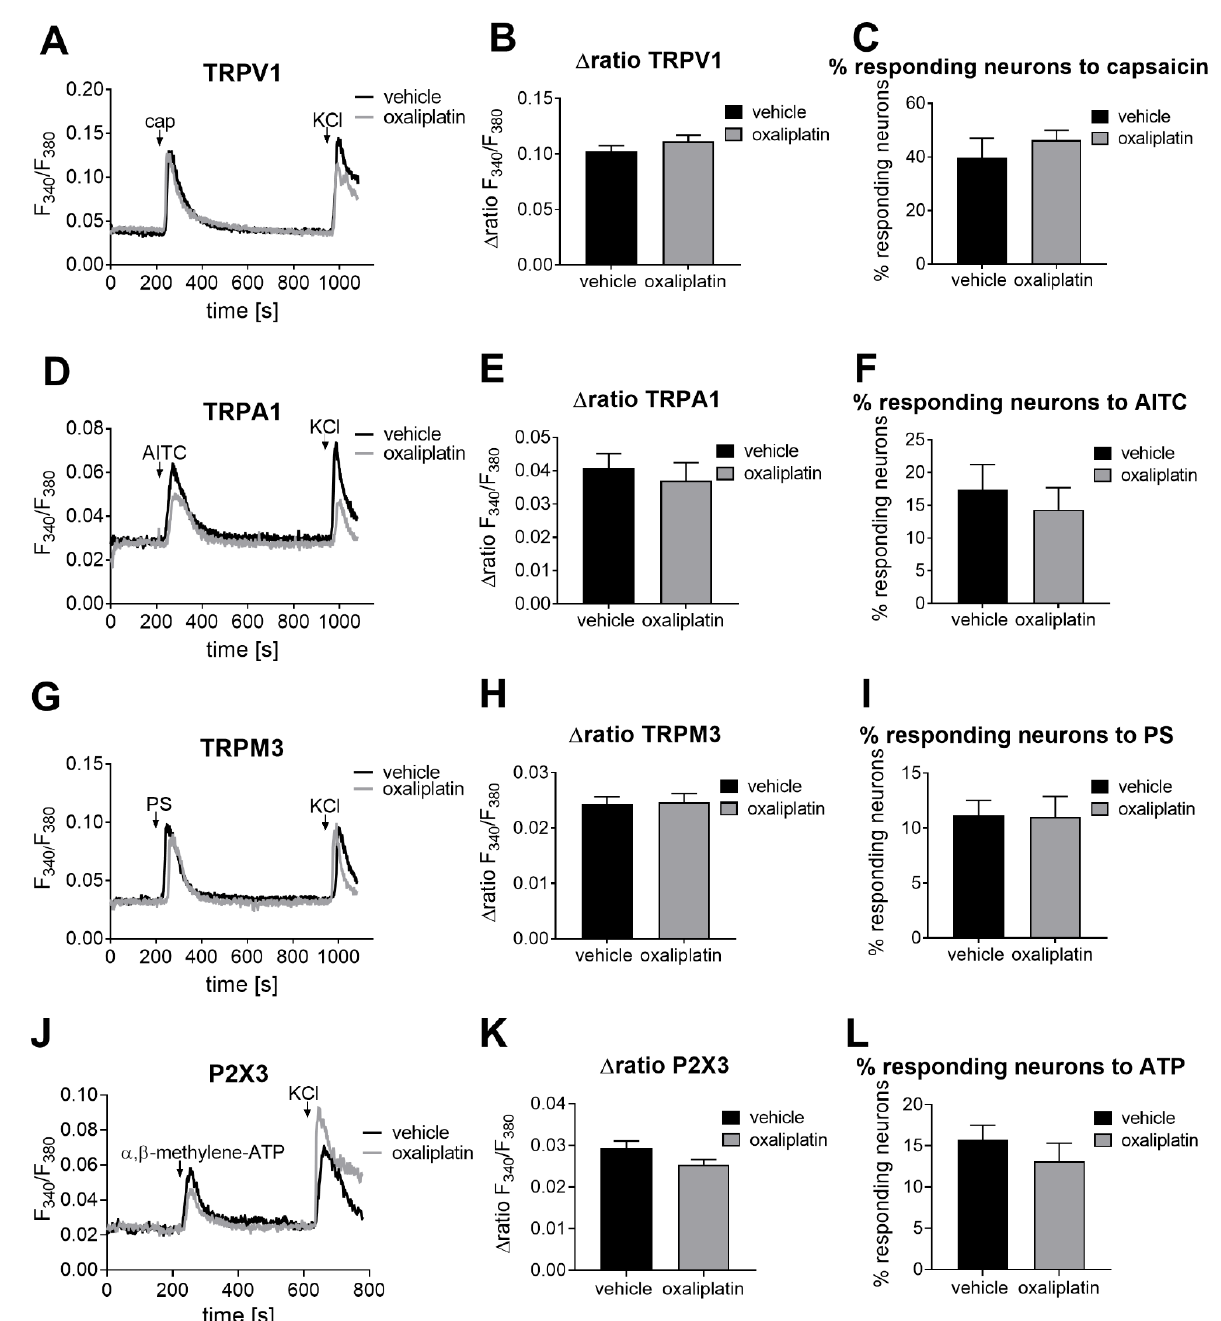
Figure 2. TRPV1, TRPA1, TRPM3 and P2X3 channel activity and number of neurons responding to their selective agonists 24 h after oxaliplatin (3 mg/kg) or vehicle treatment. ( A , D , G,J ) Representative Ca 2+ responses after ( A ) TRPV1, ( D ) TRPA1, ( G ) TRPM3, or ( J ) P2X3 channel stimulation with their corresponding agonists (( A ) TRPV1: cap (capsaicin) 200 nM, 20 s; ( D ) TRPA1: AITC (allyl isocyanate) 100 µM, 30 s; ( G ) TRPM3: PS (pregnenolone sulfate) 40 µM, 45 s; ( J ) P2X3: α,β -methylene-ATP 50 µ M, 20 s). ( B , E , H , K ) ∆ ratio F 340 /F 380 of the amplitude after a transient Ca 2+ influx after ( B ) TRPV1, ( E ) TRPA1, ( H ) TRPM3 or ( K ) P2X3 channel stimulation. Data represent the means ± SEM from n = 45–89 primary sensory neurons per condition from n = 2 – 3 mice; unpaired two-tailed t -test with Welch´s correction. ( C , F , I , L ) Percentage of neurons responding to ( C ) TRPV1, ( F ) TRPA1, ( I ) TRPM3, or ( L ) P2X3 channel agonists. Data represent the means ± SEM from n = 4–18 independent measurements per condition; unpaired two-tailed t -test with Welch’s correction. Neurons were identified by stimulating the DRG cultures with 50 mM KCl for 60